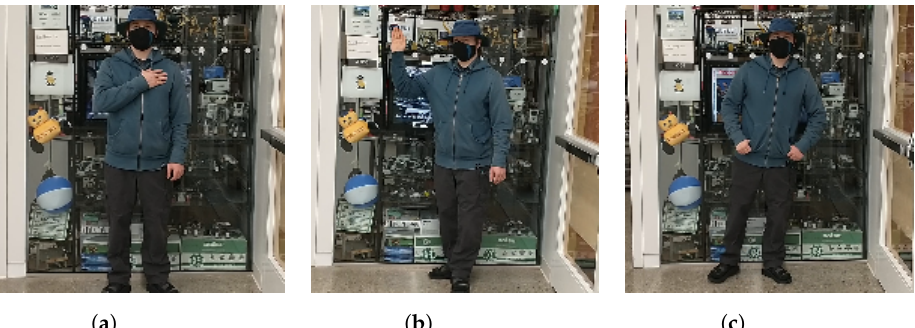
Figure 4. Examples of the testing dataset. When compared to the pictures in Figure 2, it is easy to see that the backgrounds are very different and author J. Schulte is wearing different clothes. This easily confuses basic CNN models but does not confuse our modular design. ( a ) Command to follow the user and label them as the target. ( b ) Command to stop following the user. ( c ) No Command: follow previous